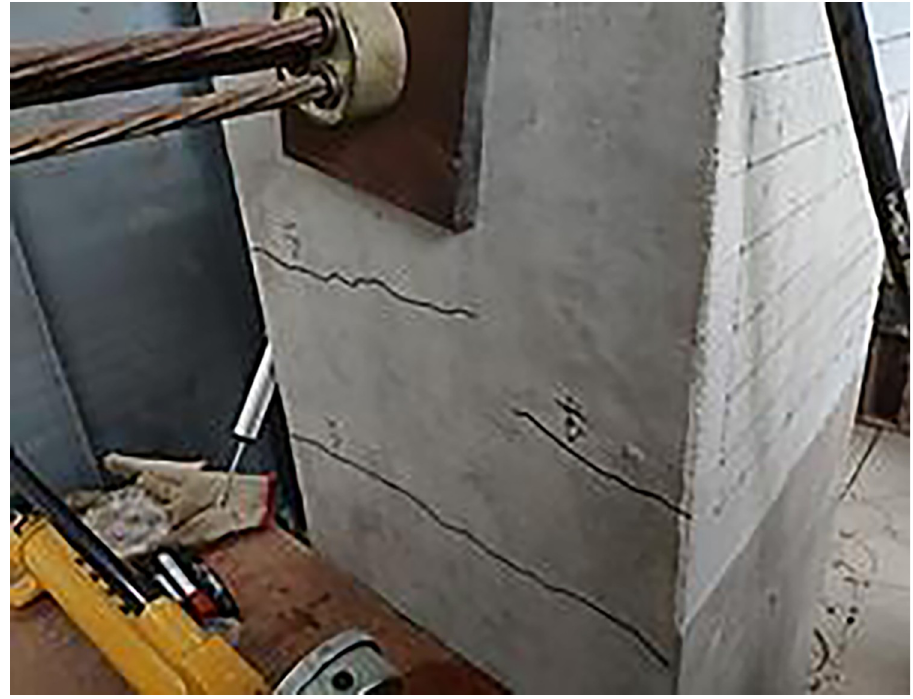
Fig 15. Failure modes of SJ-1~SJ-5